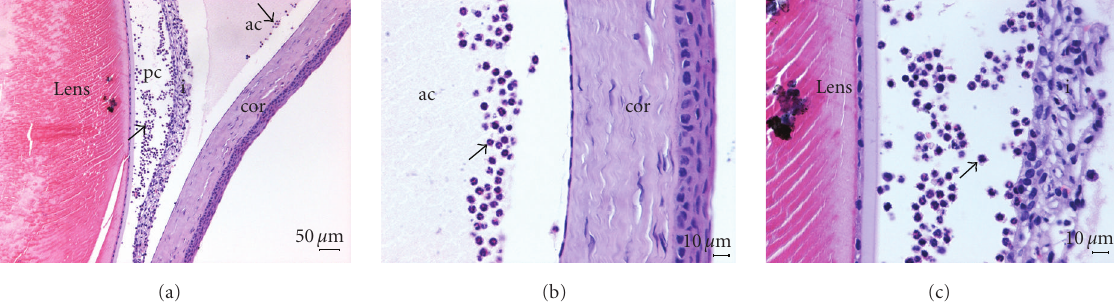
Figure 3: Histological changed after LPS immunized at 24 hours in Wistar rat (HE staining): (a) There were a lot of inflammatory cells in anterior and posterior chamber. Arrows indicated positive cells (Bar = 50 μ m). (b) There were a lot of inflammatory cells in anterior chamber. (c) There were a lot of inflammatory cells in posterior chamber (Bar = 10 μ m).